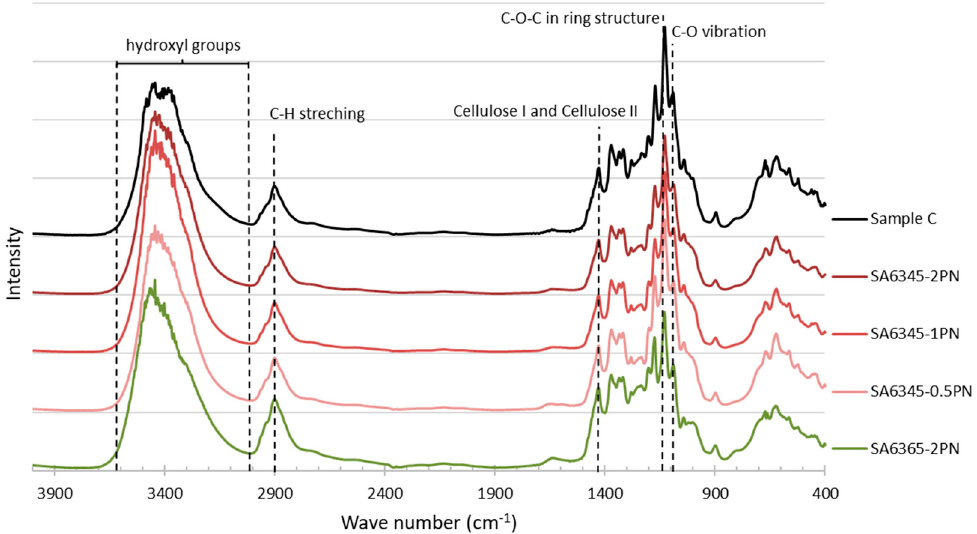
Figure 14. FT-IR spectra of all samples.